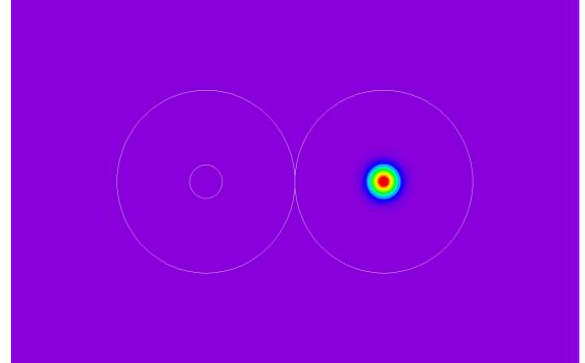
Figure 16. 2D power distribution map for the output port ( z =9910.7982 μm).